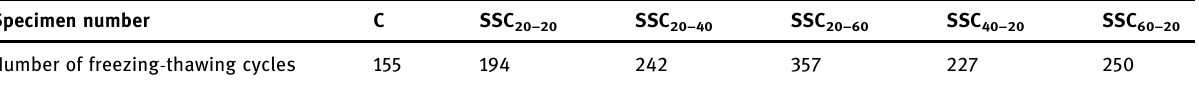
Table 10: Number of frozen and melting circulation of concrete when the relative dynamic elastic modulus reached 60% ( N )